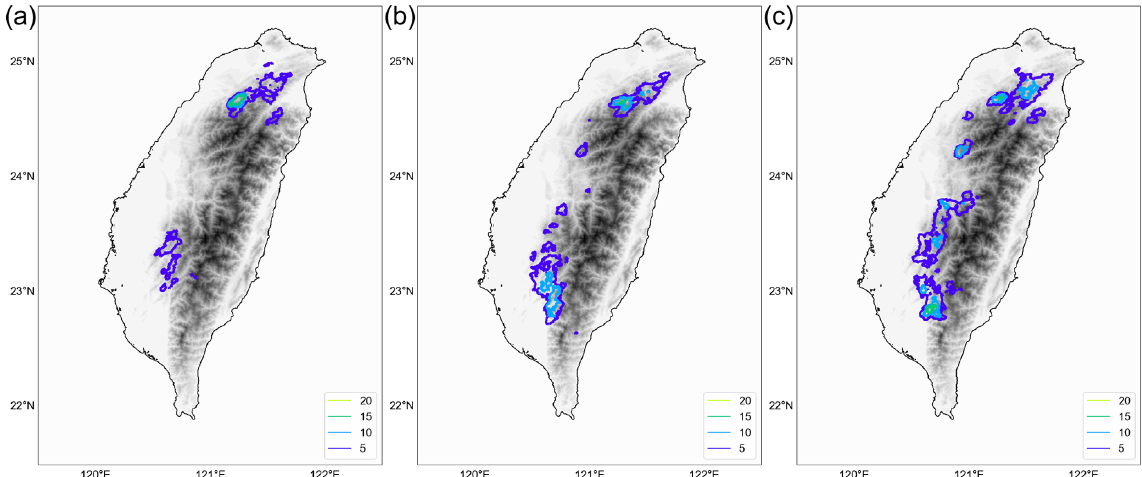
Figure B1. The occurrence counts of convective systems with a maximum rain rate greater than 100mmh − 1 when CCN concentration